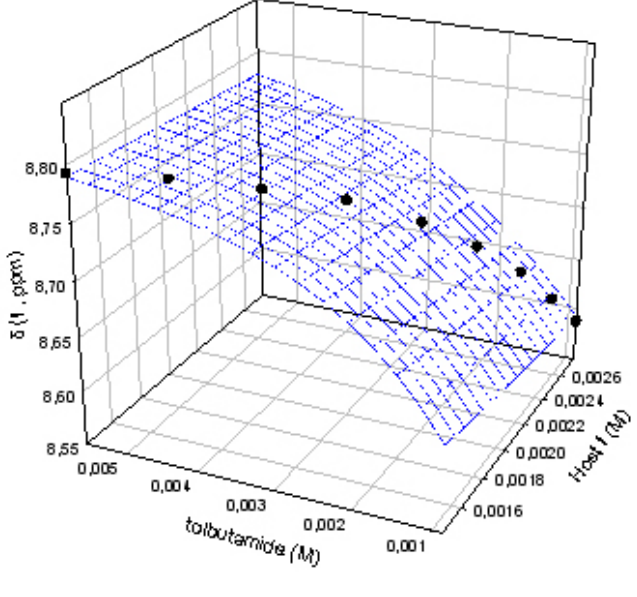
Figure 3. Titration curve for the complex I : 1